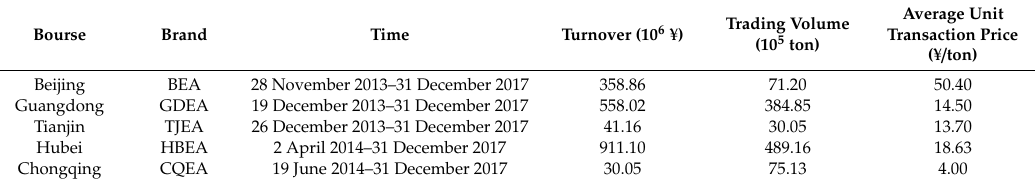
Table 1. Pilot emissions trading scheme in